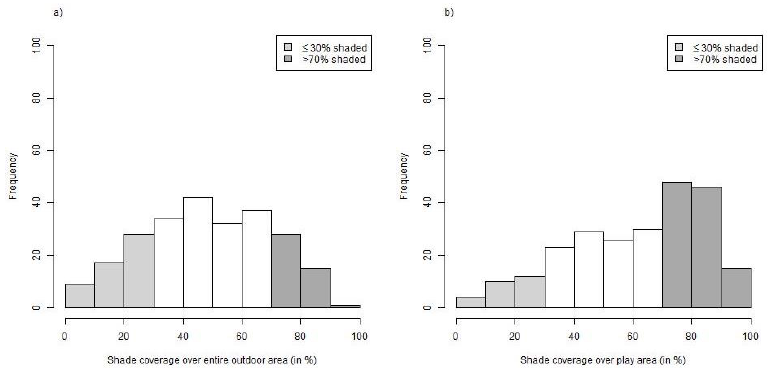
Figure 1. Histograms of shade coverage observed in 243 nurseries in Bavaria, southern Germany: ( a ) shade coverage over entire outdoor area; ( b ) shade coverage over play area. Shade coverage over areas with play structures (e.g., slides, swings or sandboxes) was higher, although still in 26 nurseries (11%) only 30% of this area was shaded (Figure 1b). Conversely, 45% of the nurseries provided more than 70% of shade over those areas. The overall mean percentage of shaded play areas was 65% (Table 1).